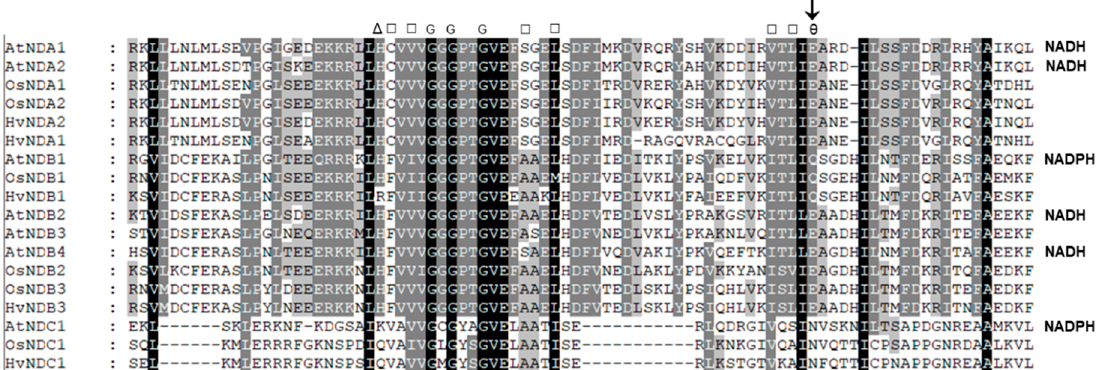
Figure 5. An alignment of the NAD(P)H binding domain in rice and barley ND families with Arabidopsis homologues. The sequences were aligned using the Clustal program. Substrate specificity is given on the right for each enzyme that has been experimentally determined [10,39,42]. Residues are Δ , basic or hydrophilic; □ , hydrophobic; ө , acidic; and G, Glycine. The acidic residue alters the specificity for NADH- and NADPH-specific proteins and is indicated as an arrow.